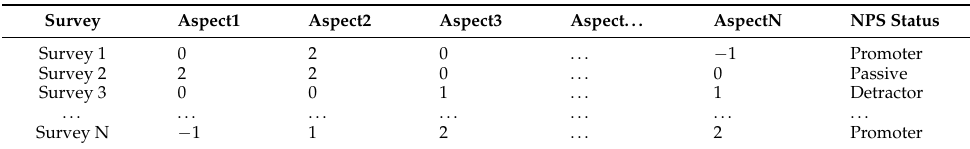
Table 1. Sentiment decision table constructed from a text survey and opinion mining procedure applied to the text.